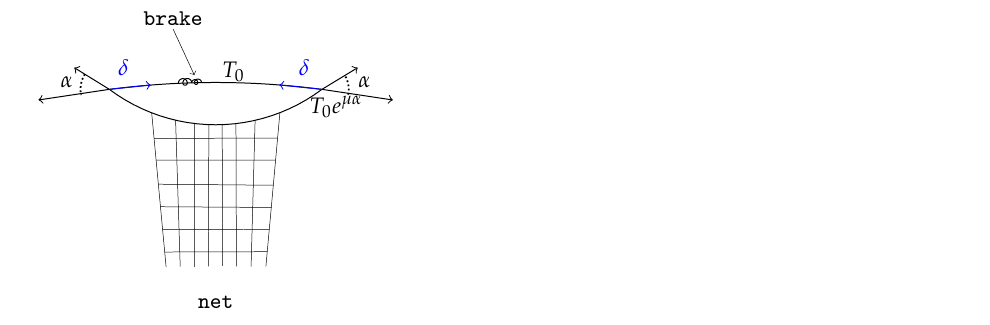
Figure 17. Detailed scheme of lateral cables (9 or 10) showing characteristic angles at shackles.